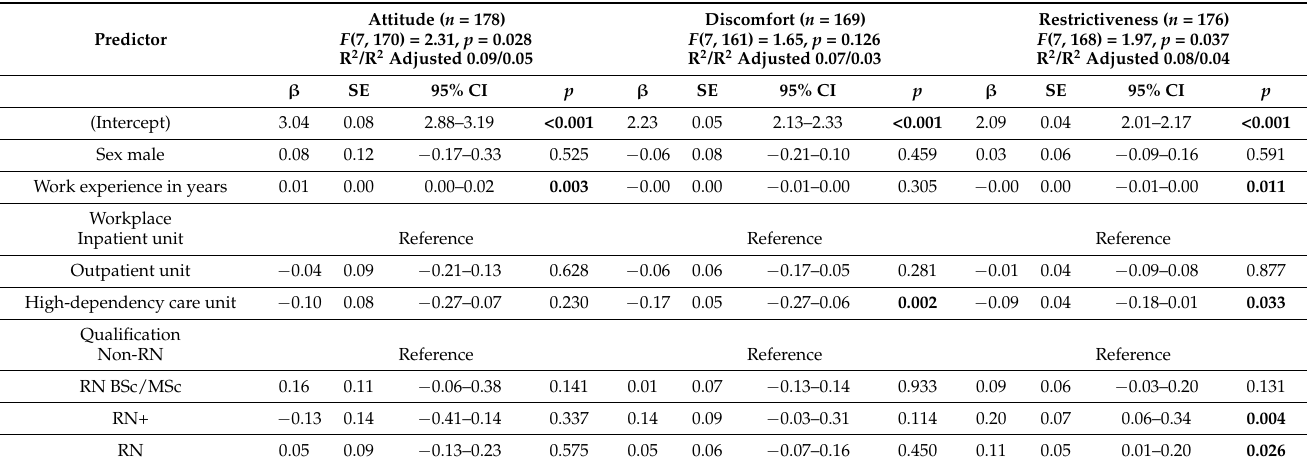
Table 2. Associations between participants’ characteristics and their general attitude towards re- straints, their discomfort in using restraints, and their perceived restrictiveness of restraints.